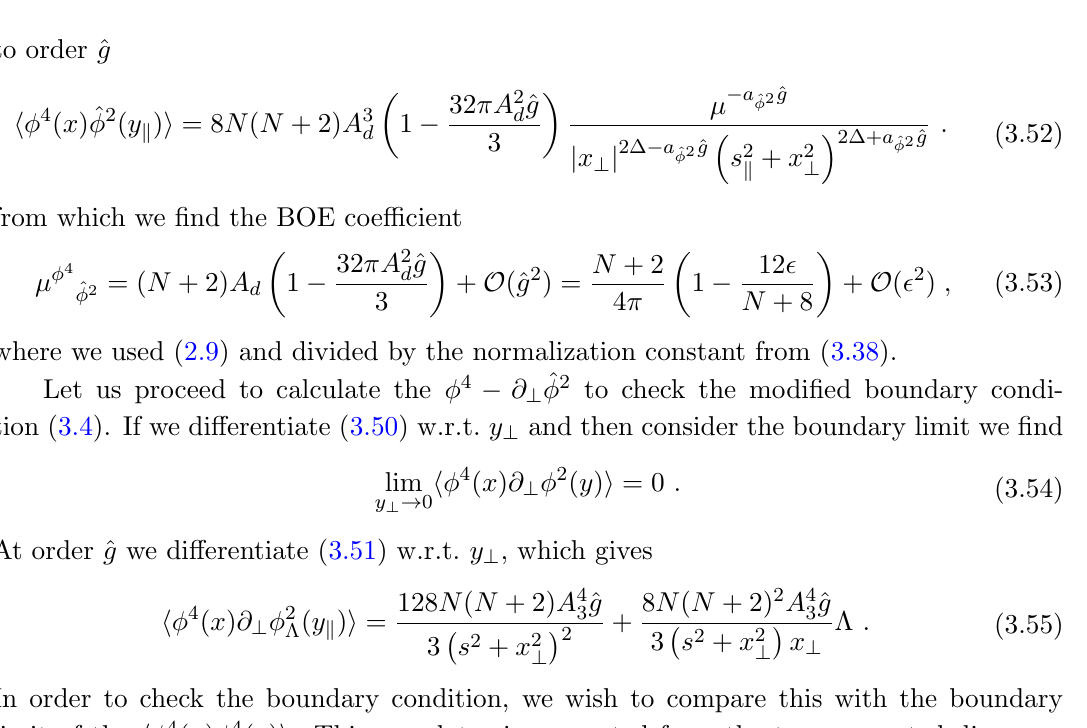
Figure 5 . The (cid:30) 4 (cid:0) (cid:30) 4 correlator in the free theory. The full dots represent the respective composite